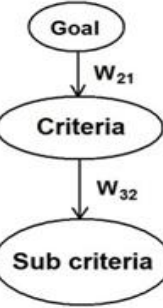
Fig. 3: The relationship between criteria and sub-criteria based on the AHP